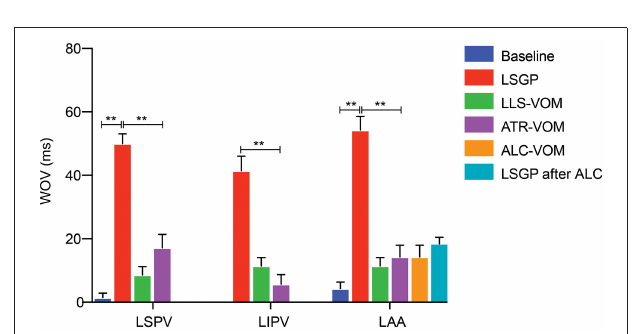
FIGURE 4 | WOV at LSPV LIPV and LAA; ** P < 0.01.